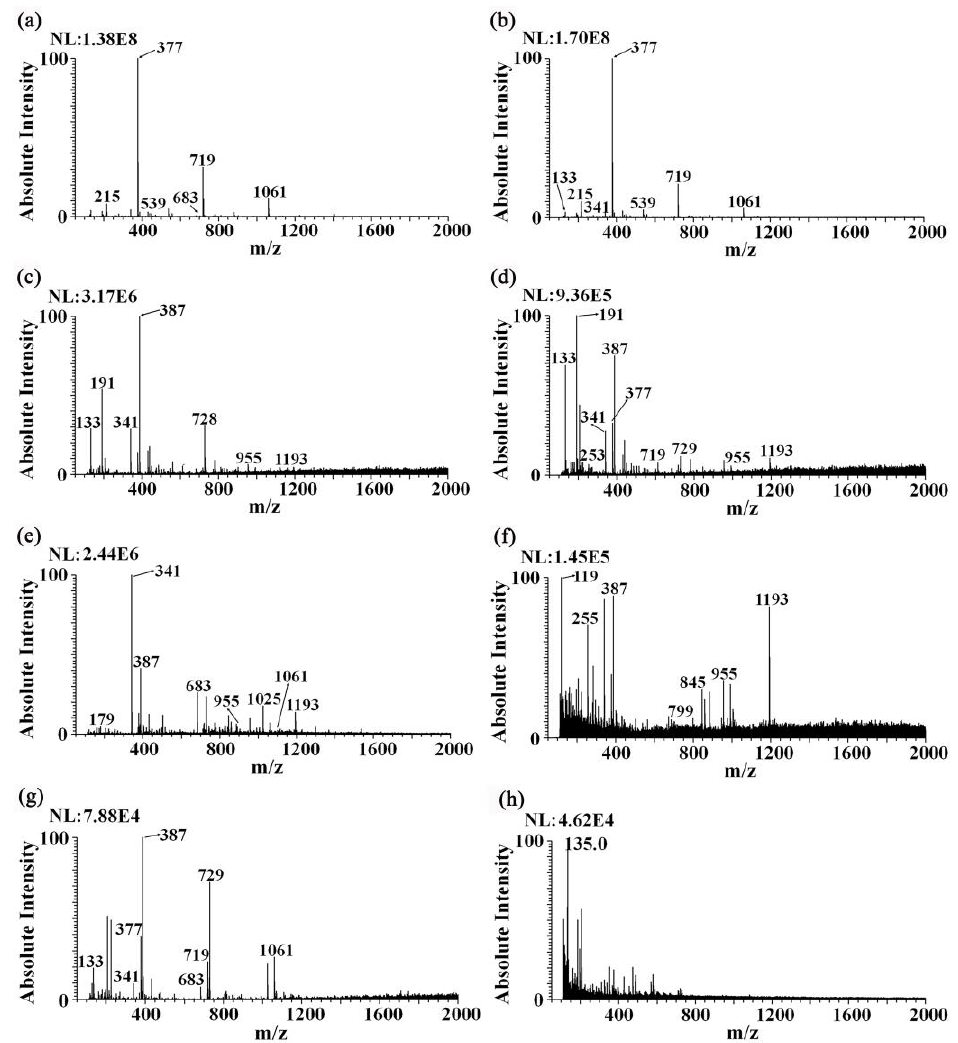
Figure 3. The fingerprint spectra of different solvents for the detection of ginseng under forest samples detected with iEESI-MS. ( a , c , e , g ) in the left column correspond to the fingerprint spectra of the ginseng under forest samples under 0.5 mM ammonium chloride in methanol, 0.1% formic acid in water/ethanol ( v : v = 1:1), 10 mM ammonium acetate in acetonitrile/methanol ( v : v = 1:1), and 0.1% formic acid in acetonitrile/ethanol ( v : v = 1:1) solvents, respectively; ( b , d , f , h ) in the right column correspond to the fingerprint spectra of the ginseng under forest samples extracted sequentially in 0.5 mM ammonium chloride in methanol, 0.1% formic acid in water/ethanol ( v : v = 1:1), 10 mM ammonium acetate in acetonitrile/methanol ( v : v = 1:1), and 0.1% formic acid in